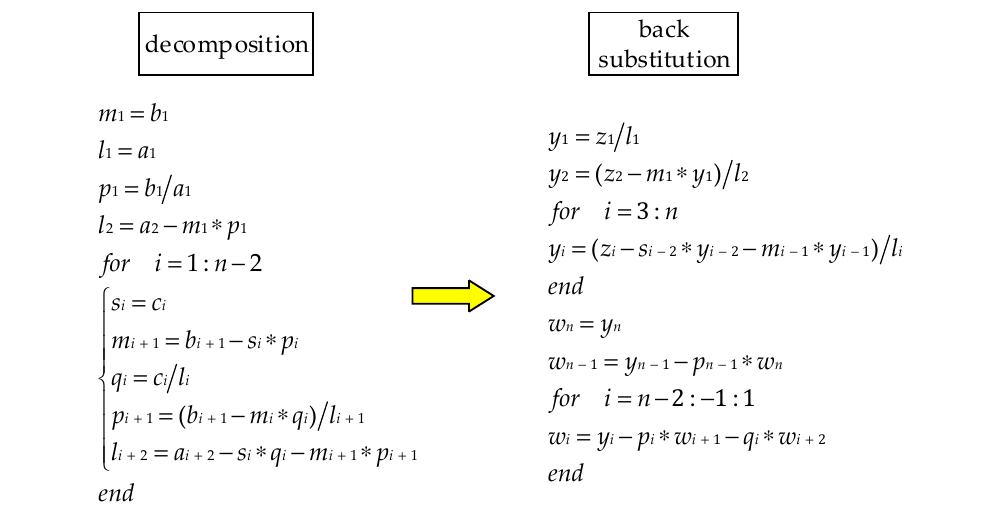
Figure 9. Flow chart of Thomas method.